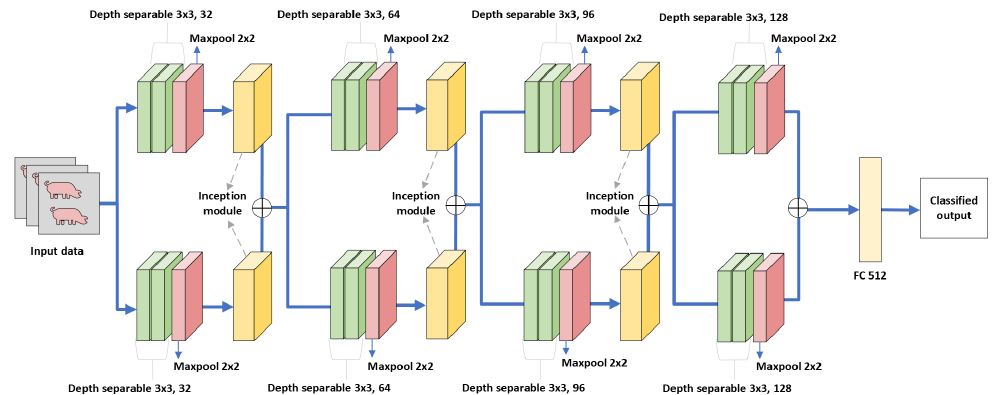
Figure 5. DISubNetV2: Depthwise separable convolution with inception module subnetwork. In this model, the inception modules are concatenated and fed as input to subsequent layers.